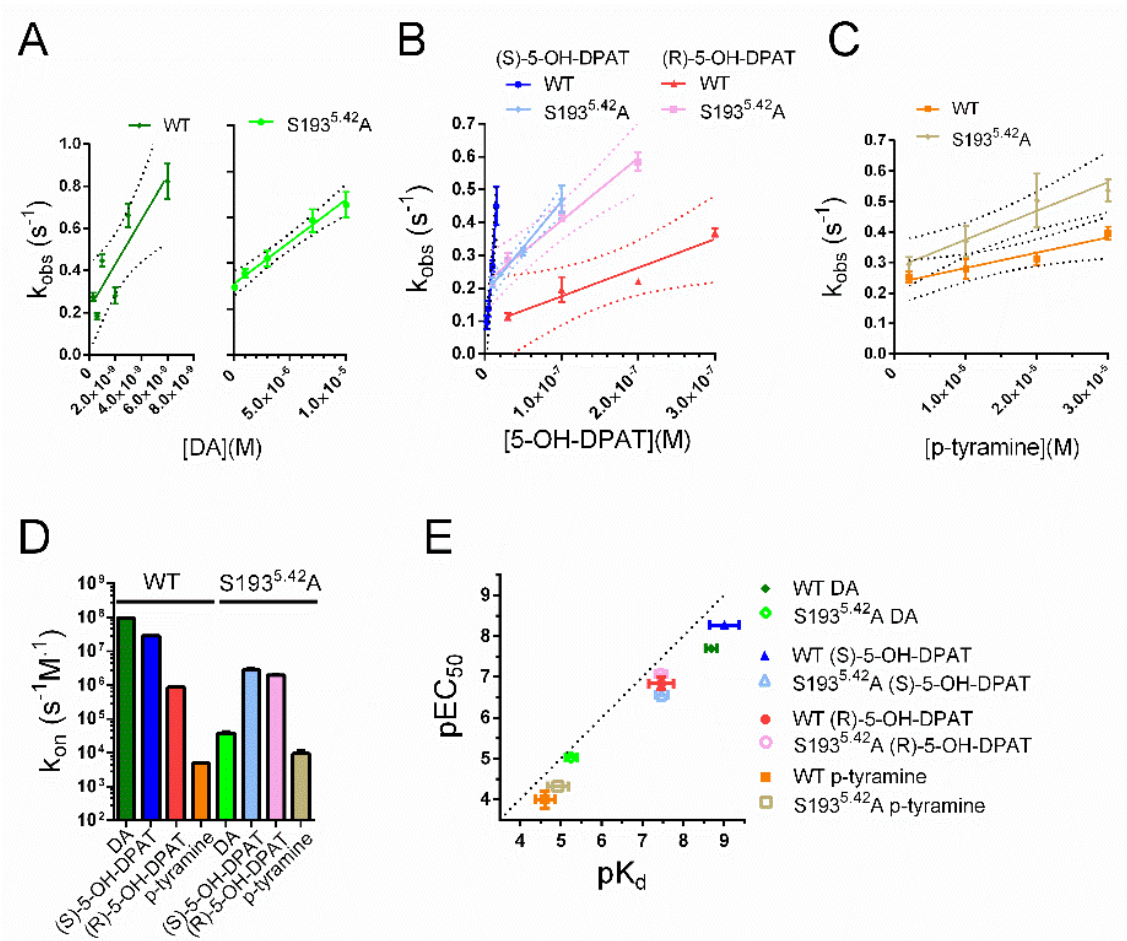
Figure 3. Estimation of agonist k on at WT and S193 5.42 A mutant D 2 R. Individual concentrations of ( A ) DA, ( B ) (S)-5-OH-DPAT and (R)-5-OH-DPAT, and ( C ) p-tyramine were added to oocytes co-expressing WT D 2 R or D 2 R S193 5.42 A with RGS4 and GIRK1/4. The rates of rise (k obs ) of the resulting current responses have been plotted against the corresponding agonist concentrations and linear fits (solid lines) and their 95% confidence bands (dotted lines) are shown. Experiments were performed using a perfusion rate of 4.5 mL/min. ( D ) Summary statistics for k on , estimated from the slopes of the linear fits to k obs shown in ( A ), ( B ), and ( C ). Shown are mean k on estimates for DA (WT: 9.70 ± 1.23 × 10 7 s − 1 × M − 1 , S193 5.42 A: 3.69 ± 0.48 × 10 4 s − 1 × M − 1 ), (S)-5-OH-DPAT (WT: 2.86 ± 0.31 × 10 7 s − 1 × M − 1 , S193 5.42 A: 2.82 ± 0.34 × 10 6 s − 1 × M − 1 ), (R)-5-OH-DPAT (WT: 8.65 ± 1.21 × 10 5 s − 1 × M − 1 , S193 5.42 A: 1.95 ± 0.15 × 10 6 s − 1 × M − 1 ), and p-tyramine (WT: 4.94 ± 1.15 × 10 3 s − 1 × M − 1 , S193 5.42 A: 9.41 ± 2.34 × 10 3 s − 1 × M − 1 ). Note the logarithmic y-axis. ( E ) Relations between kinetic pK d s, derived from k off and k on , and pEC 50 s, obtained from the concentration–response experiments shown in Figure 1, at WT D 2 R and S193 5.42 A. The correlation between pEC 50 s and kinetic pK d s for all four agonists at both WT and S193 5.42 A mutant D 2 R was statistically significant (Spearman’s r = 0.9048, p = 0.0046) for all four pairs. Data are presented as mean ±